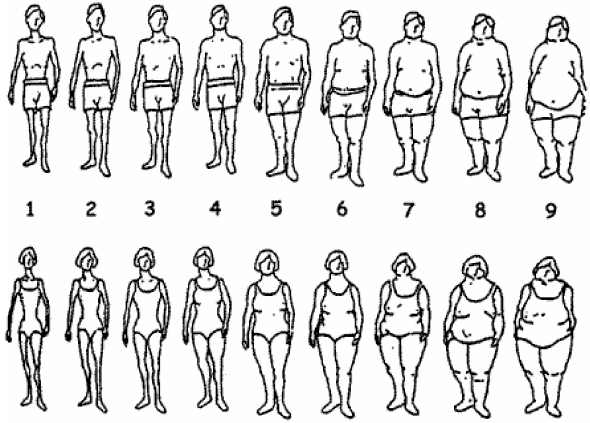
Fig. 2. Figure rating scale (FRS) by Steiger, Fraenkel, and Le- ichner